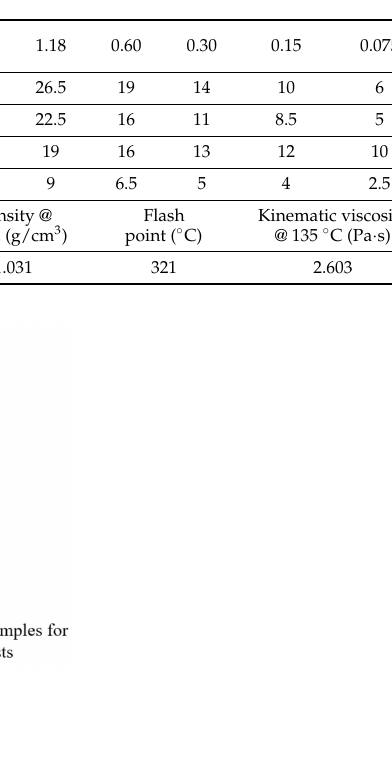
Table 2. Information of aggregates and asphalt binder.